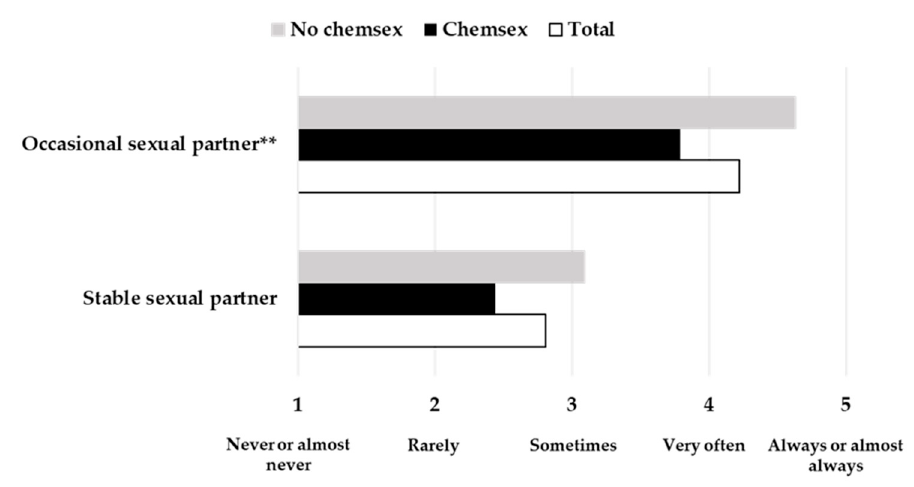
Figure 3. Frequency of condom use for all participants and for practitioners and non-practitioners of Chemsex separately, with occasional and stable sexual partners. ** p < 0.01.